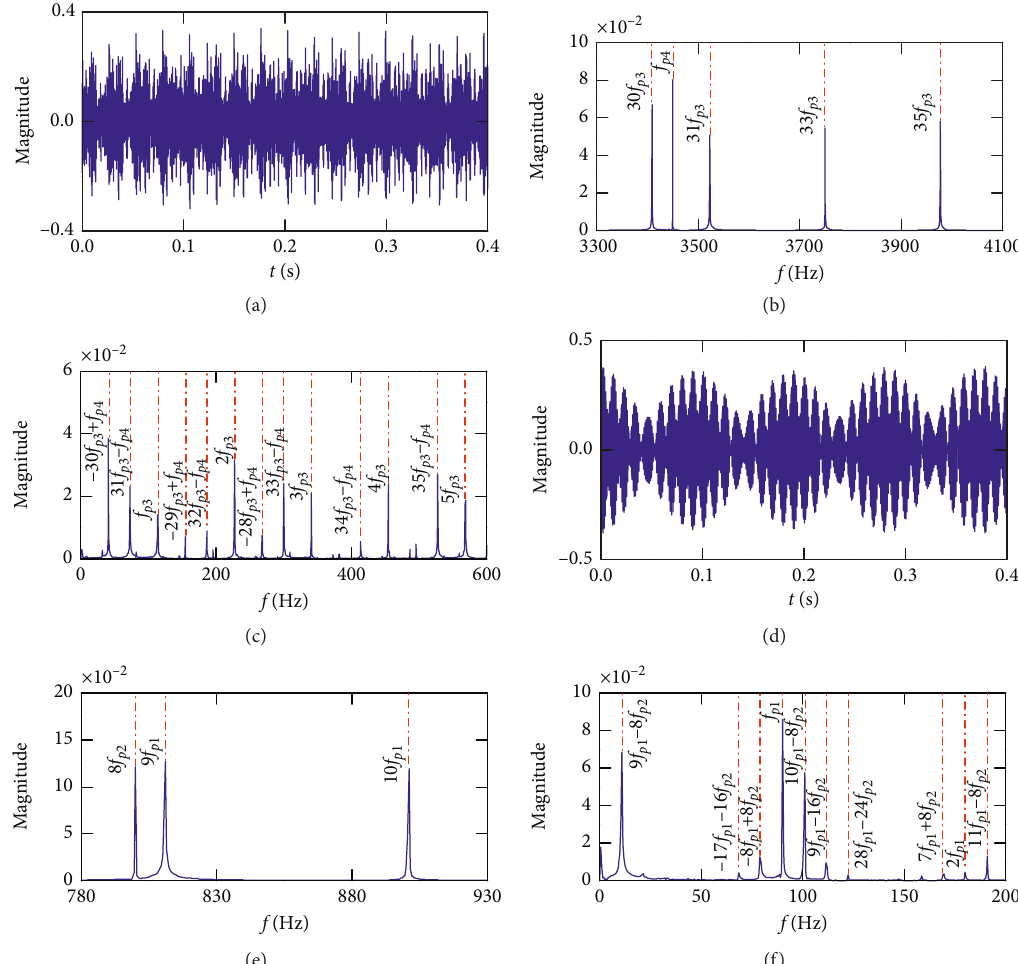
Figure 8: Results obtained by Hankel-based SVD: (a) extracted signals from the first IMF; (b) Fourier spectrum of (a); (c) envelope spectrum of (a); (d) extracted signals from the third IMF; (e) Fourier spectrum of (d); (f) envelope spectrum of (d).